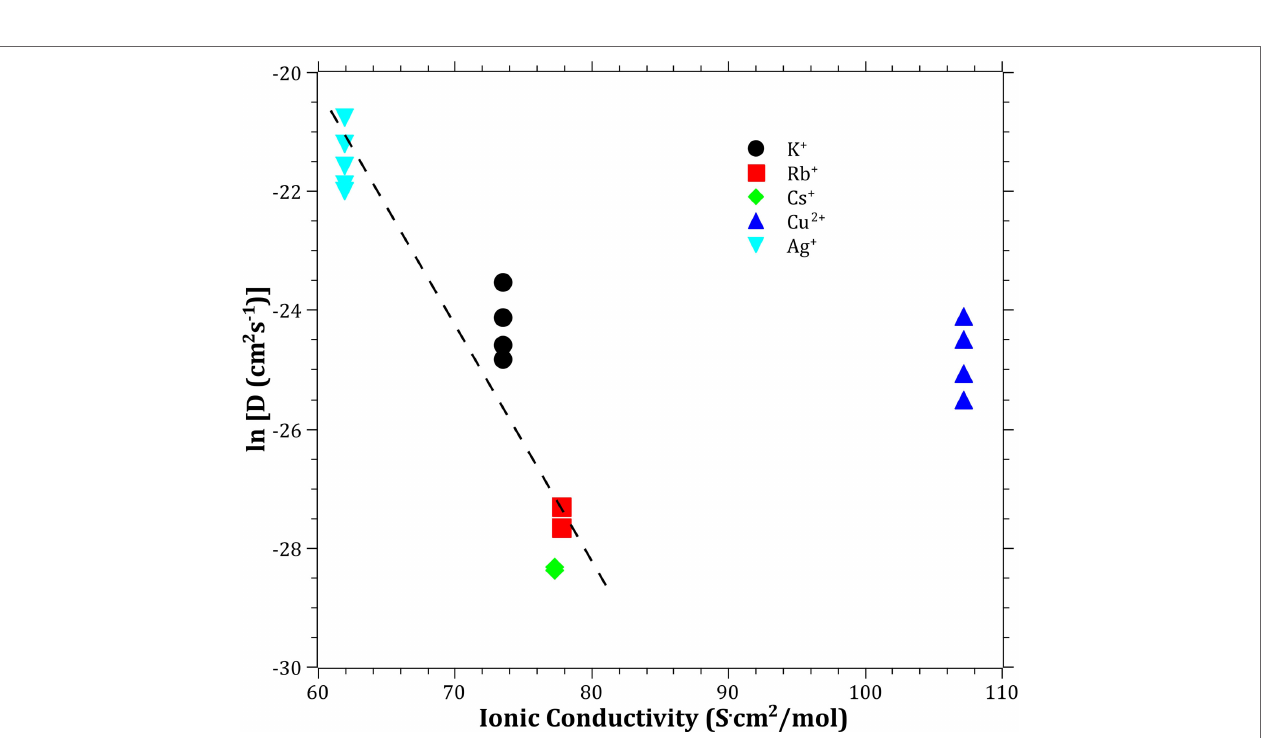
FiGUre 8 | Logarithm of the effective diffusion coefficient vs. electronic cation polarizability . Molar refraction data taken from Pauling (1927). The dashed line is a guide to the eye.